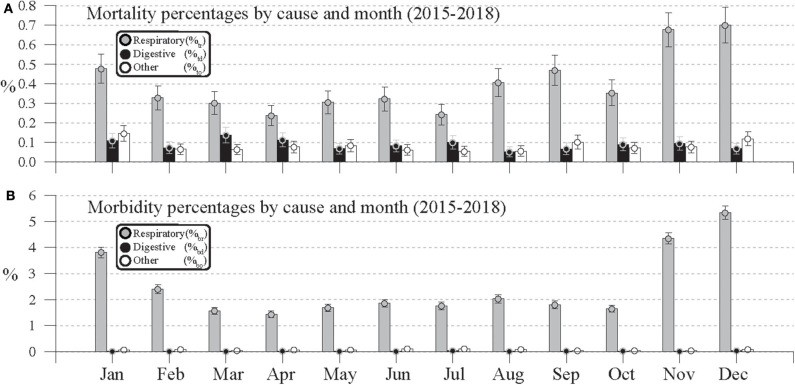
Monthly (A) mortality percentage and (B) morbidity percentages for respiratory, digestive, and other causes calculated from mortality, morbidity, and total head counts aggregated by month during January 2015 to December 2018.